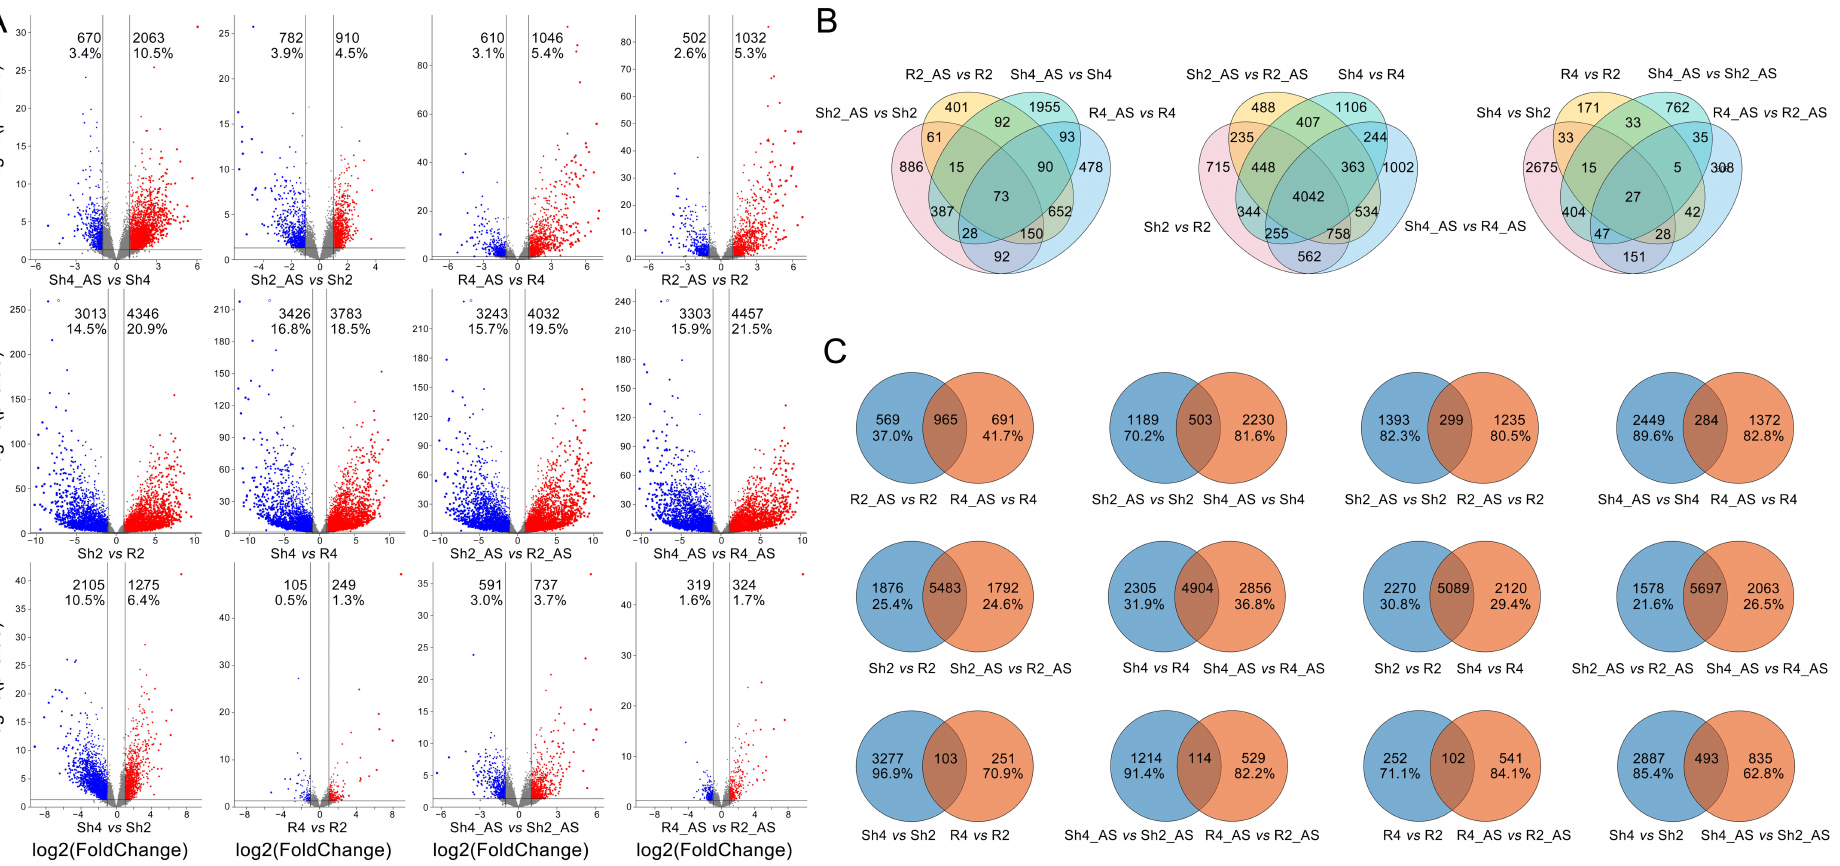
Figure 5. Differentially expressed genes (DEGs) between the roots and shoots of 9311-2x and 9311-4x rice plants under mock and high pH conditions. ( A ) The number of upregulated (blue) and downregulated (red) DEGs, which are marked at the top. ( B ) Common and unique DEGs between roots and shoots. ( C ) Details of the DEGs between all samples. R2 and R4 represent the root samples derived from 9311-2x and 9311-4x plants, respectively. R2_AS and R4_AS represent the alkaline stress treated root samples derived from 9311-2x and 9311-4x plants, respectively. Likewise, Sh2 and Sh4 represent the shoot samples derived from 9311-2x and 9311-4x plants, respectively. Sh2_AS and Sh4_AS represent the alkaline stress treated shoot samples derived from 9311-2x and 9311-4x plants,